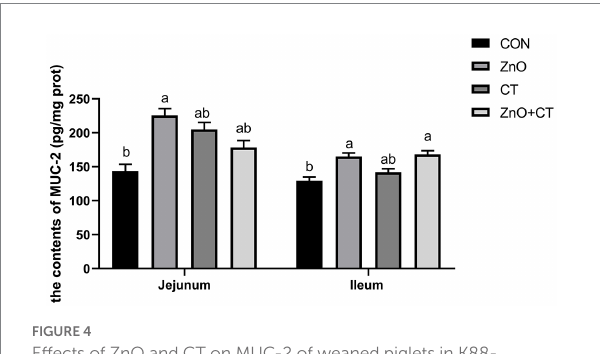
FIGURE 4 Effects of ZnO and CT on MUC-2 of weaned piglets in K88- challenged environment. MUC-2 = mucin-2. Values are means and standard errors represented by vertical bars ( n = 6). a,b Means lacking common superscript letter indicated significant differences ( p < 0.05).